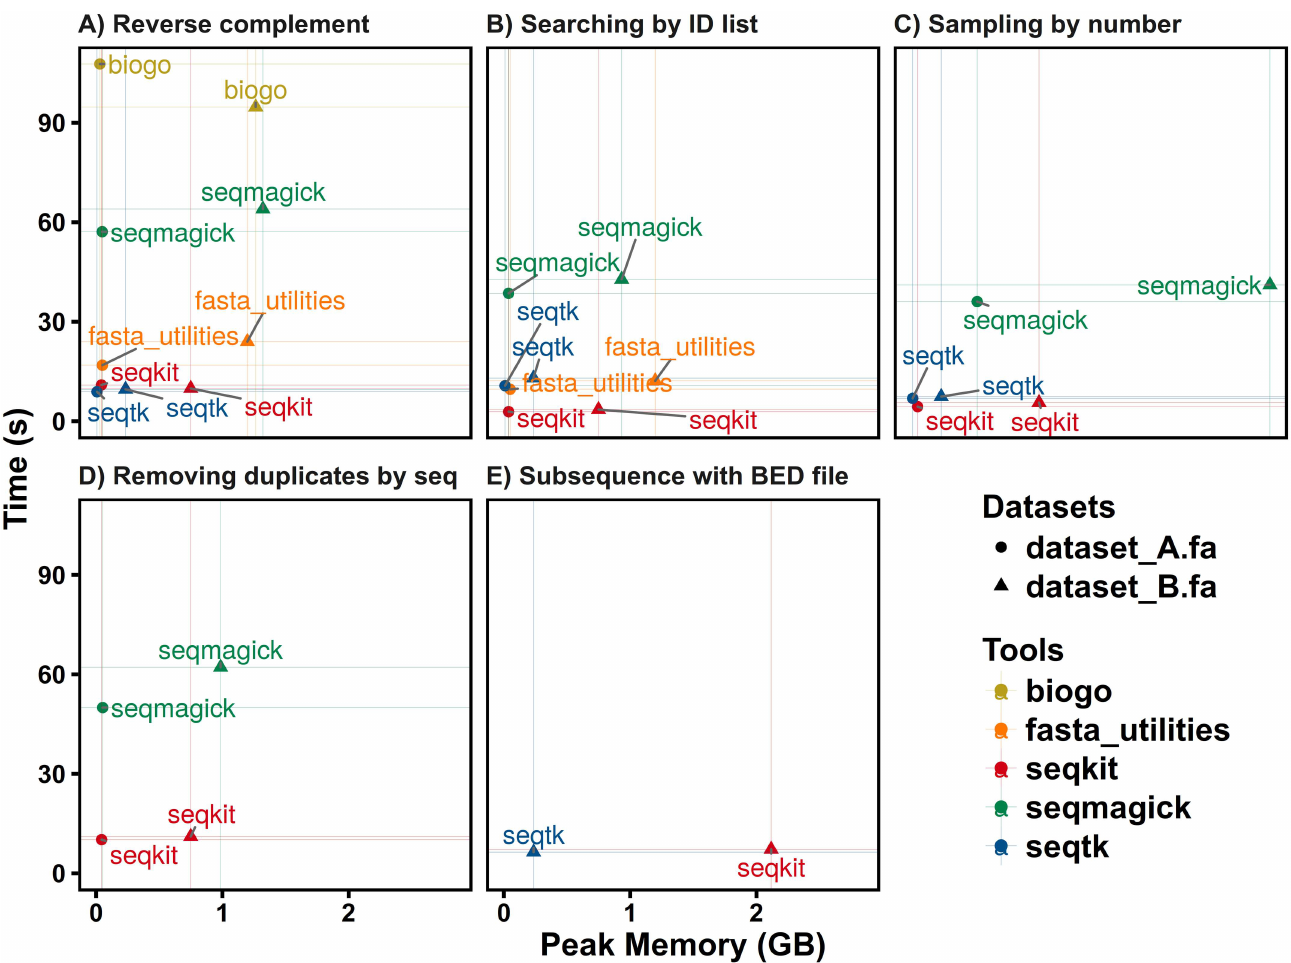
Fig 2. Performance comparison on five manipulations of FASTA file. Dataset A consists of 67,748 DNA sequences with averagelength of 41 Kb and dataset B is the human genome with 24 chromosomes, one mitochondrial sequenceand 169 scaffolds. All tests were repeated three times, and the average time or memory usage was computed. See supplementary data for details of test data and